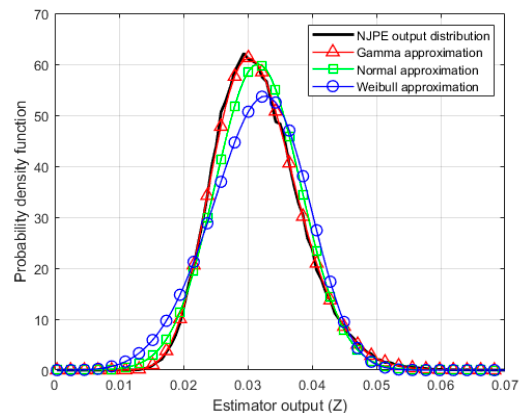
Figure 2. Probability-density functions of fitted distributions. Table 2. Root mean squared errors (RMSEs) of moments of fitted distributions.